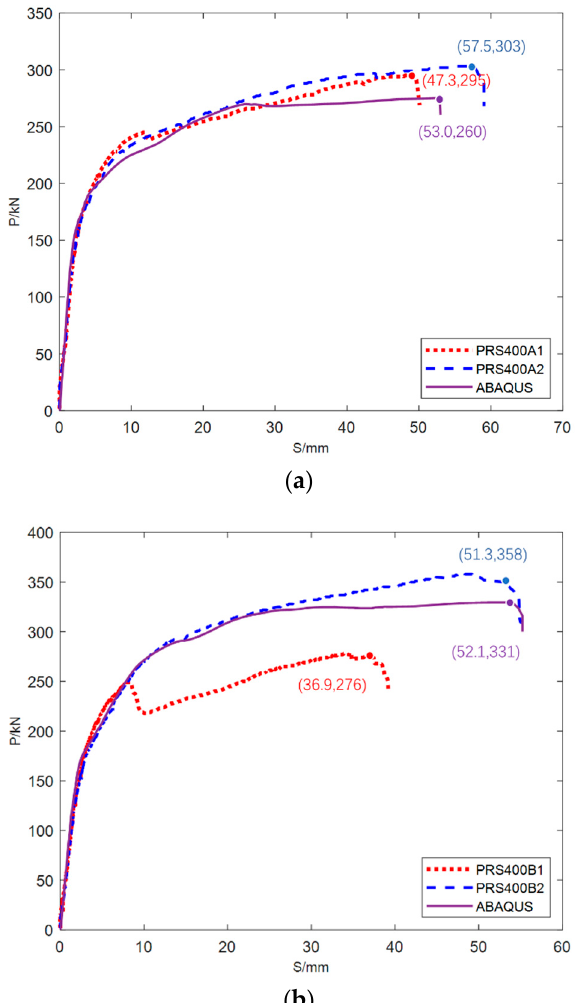
Figure 11. Comparison of force-deflection curves of specimens ( a ) Specimen PRS400A1 and Specimen PRS400A2. ( b ) Specimen PRS400B1 and Specimen Table 5. Comparison of numerical simulation results, test results, and formula calculations of flex- ural properties of specimens.